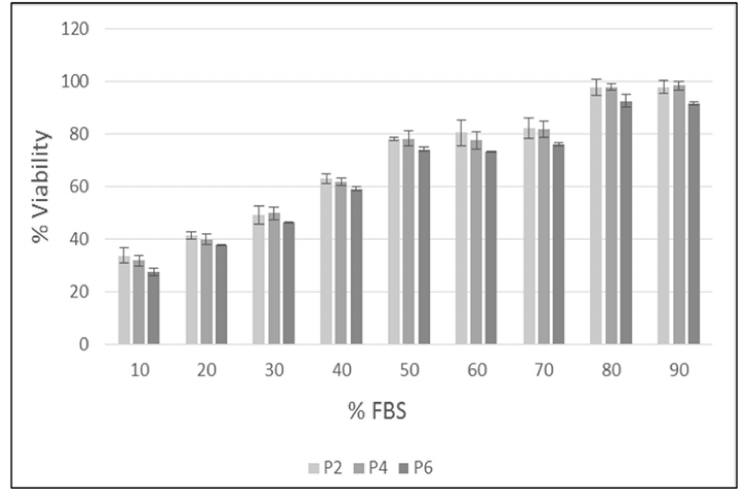
Figure 2. The effect of the different freezing solution composed of 10% DMSO and increasing percentage of FBS (from 10% to 90%) on post-thaw viability of cAD-MSCs at three passages (P2, P4 and P6).